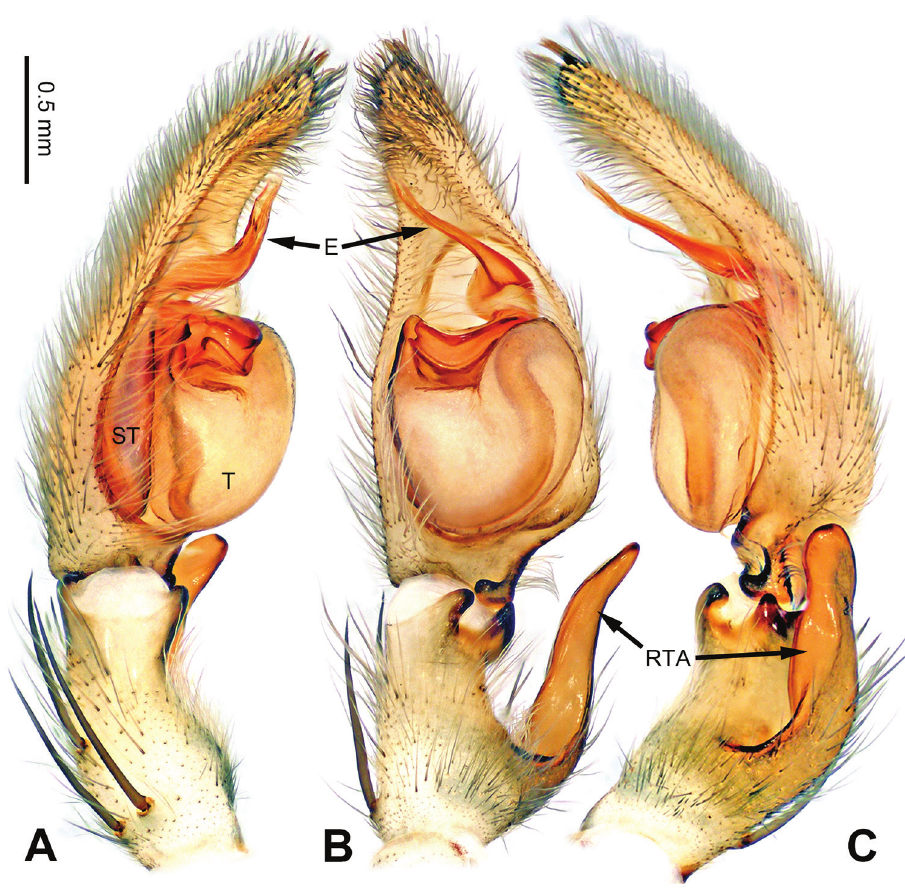
Figure 3. Pseudopoda colubrina Zhao & Li, sp. n., left palp of male holotype. A Prolateral view B Ventral view C Retrolateral view. Scale bar equal for A, B, C